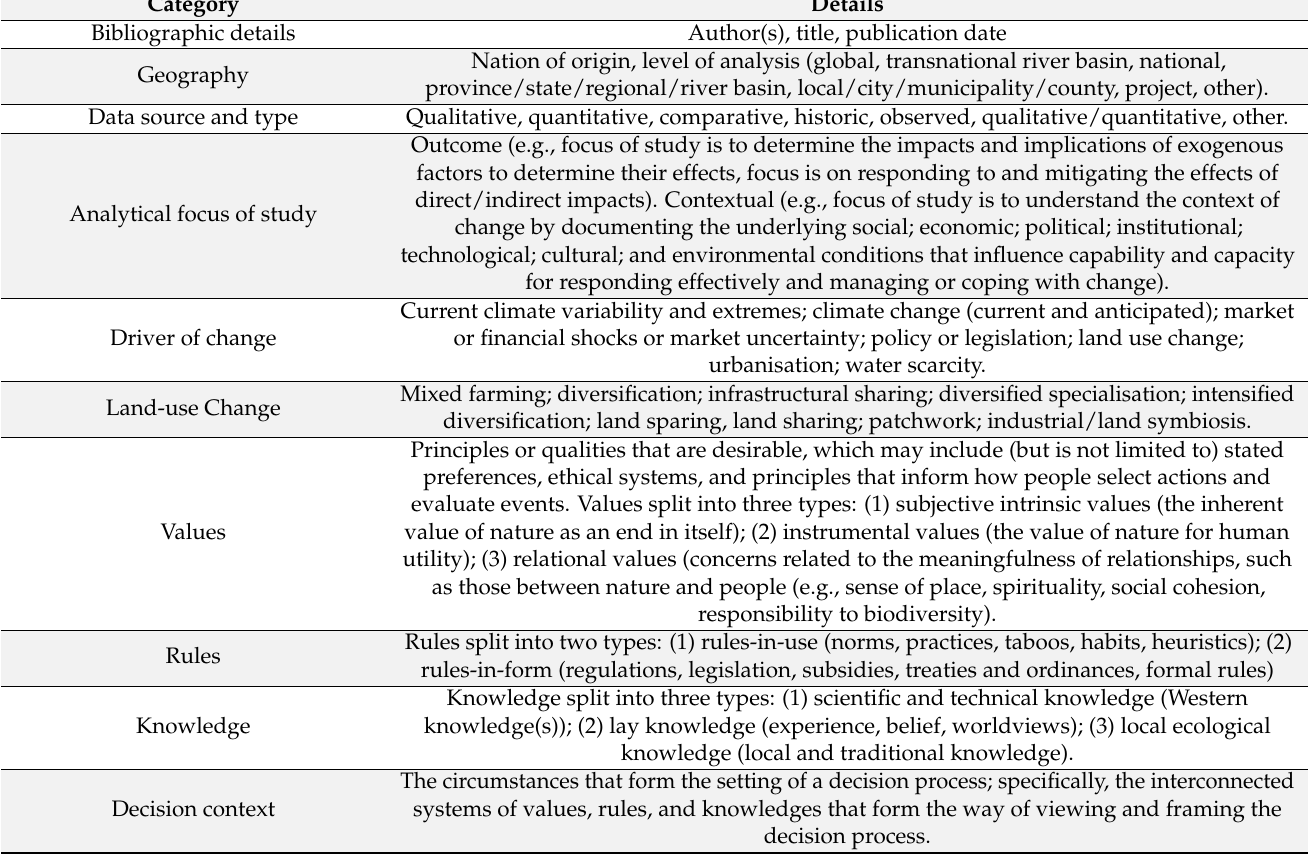
Table 2. Criteria used in the data extraction, organisation, and analysis